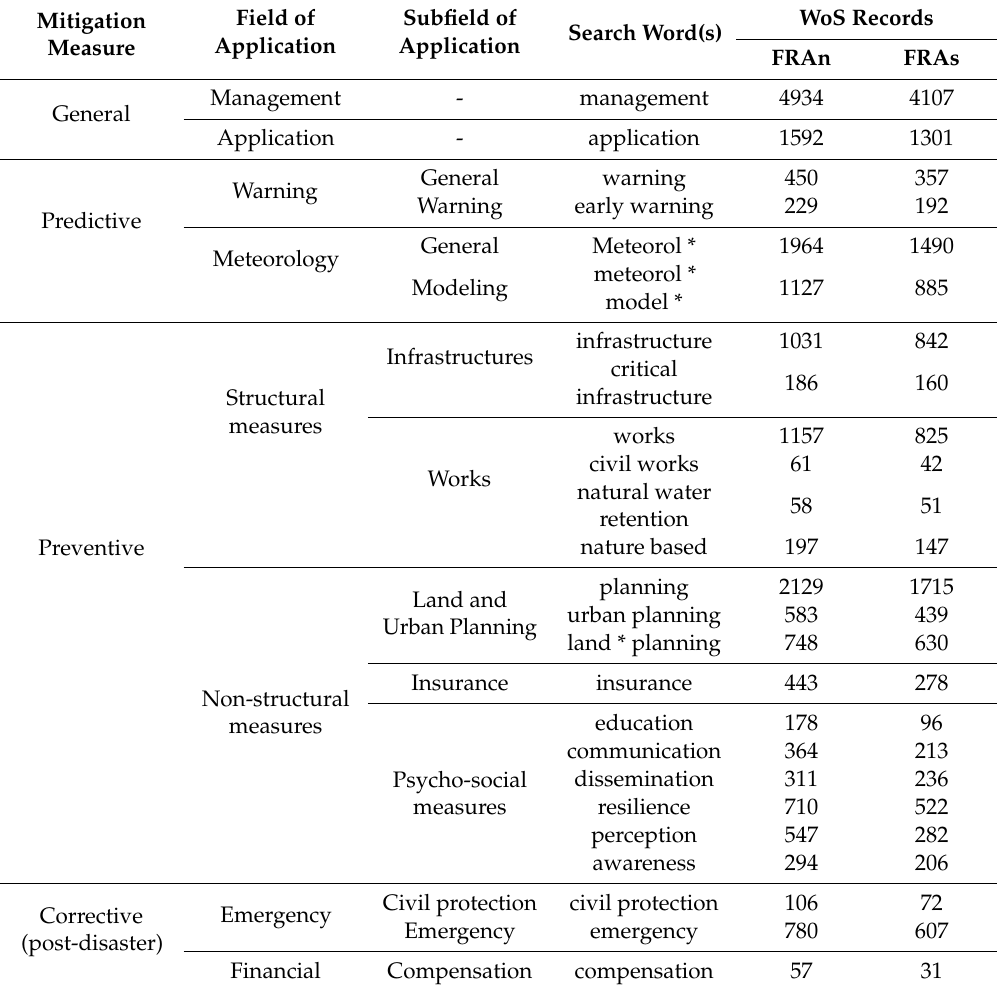
Table 5. Number of records in the Web of Science (WoS) database regarding di ff erent fields of applications of “flood risk assessment”. The asterisk (*) is a commonly used wildcard symbol that broadens a search by finding words that start with the same letters. Searched on 17 March